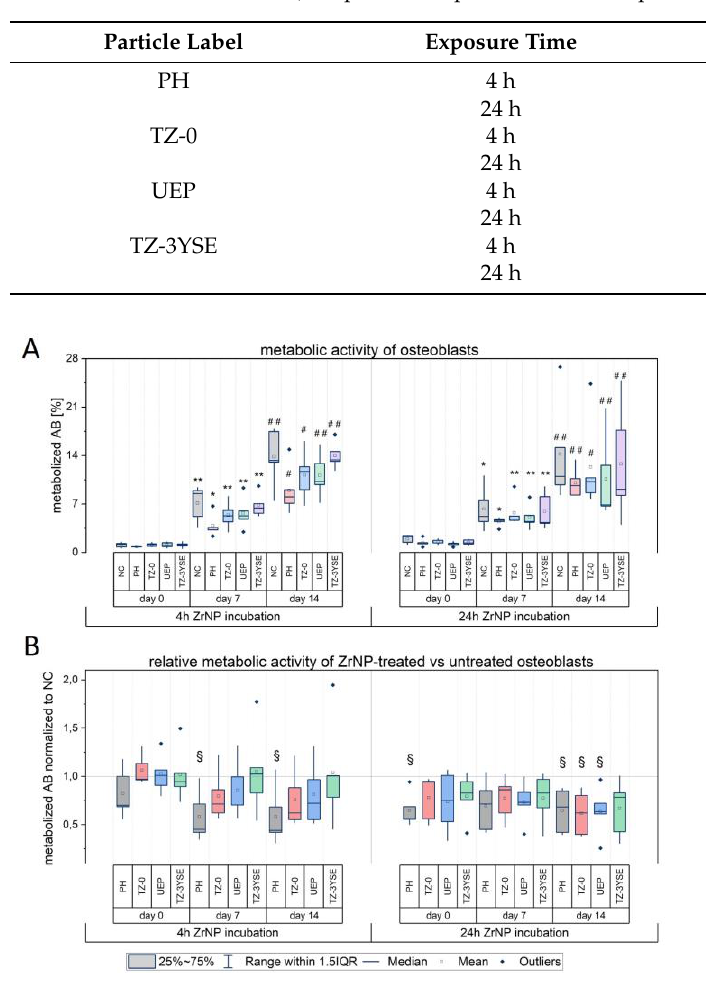
Table 2. Summarized results of the SIMS analysis of cell cultures incubated with differently-sized ZrNP for 4 h and 24 h. n = 2 (independent experiments with duplicates).